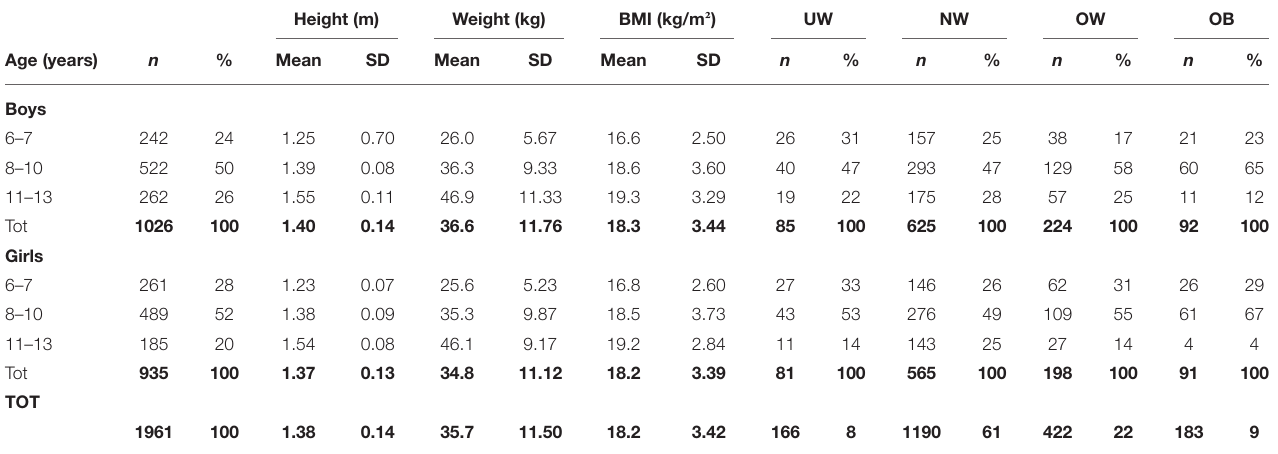
TABLE 1 | Descriptive statistics for weight status categories and gender classes stratified by age groups.